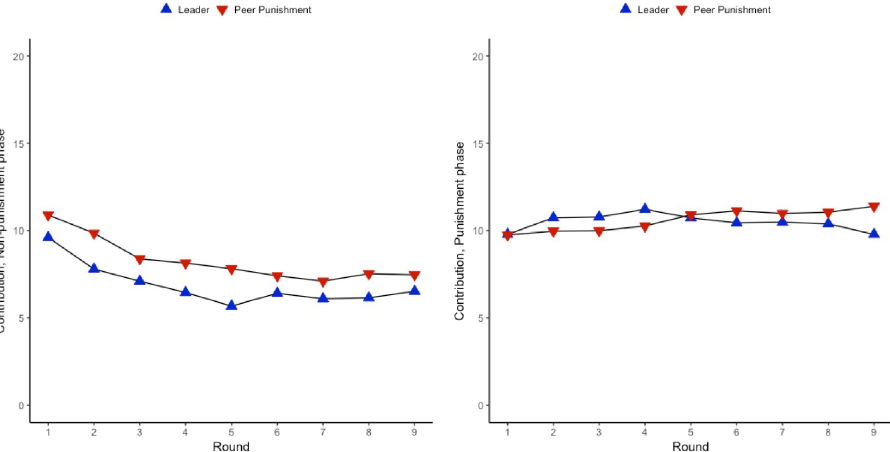
Fig 1. Contribution to the public good across conditions, non-punishment phase (1a) and punishment phase (1b).